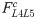
Results for Fc in RT1.Box (A): axial compression force at level L4L5 (FL4L5c), computed in relation to changes in sacral slope (SS) and pelvic incidence (PI) in RT1. The results for the three sagittal vertical axis (SVA) conditions interpreting the balanced global alignment (SVAmed) and backward and frontward imbalanced alignments (SVAback and SVAfront) are presented as green, blue, and red surfaces, respectively. The two boxes (B and C) on the right present the results in the SS and PI perspectives, respectively.